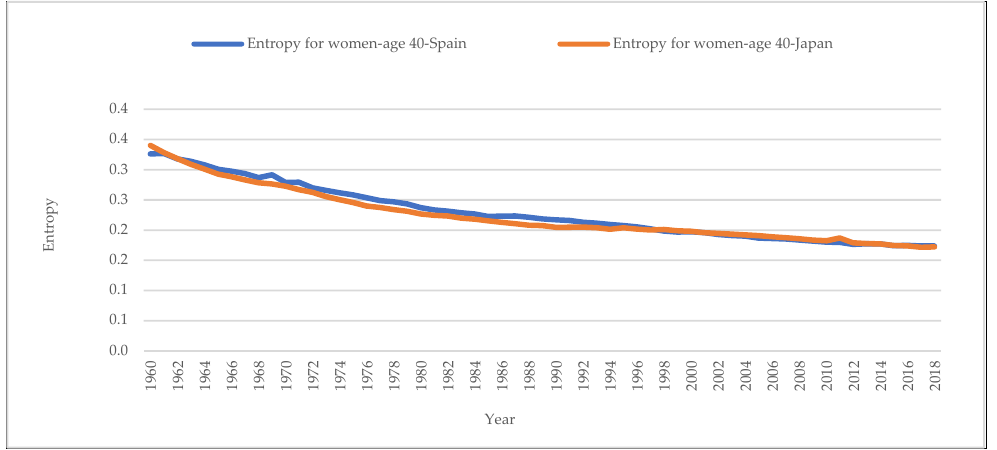
Figure 10. Entropy evolution of the female population at 40 over calendar years. Source: authors.